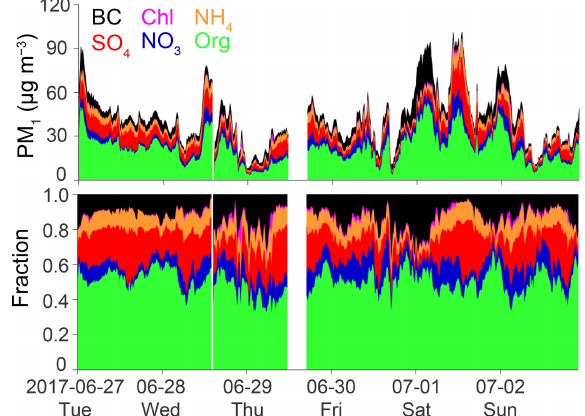
Figure 10. Time series of PM 1 species (Org, Chl, NH 4 , NO 3 , SO 4 , and BC) – stacked absolute concentrations and fraction of PM 1 – for a relatively less polluted (warm) period.